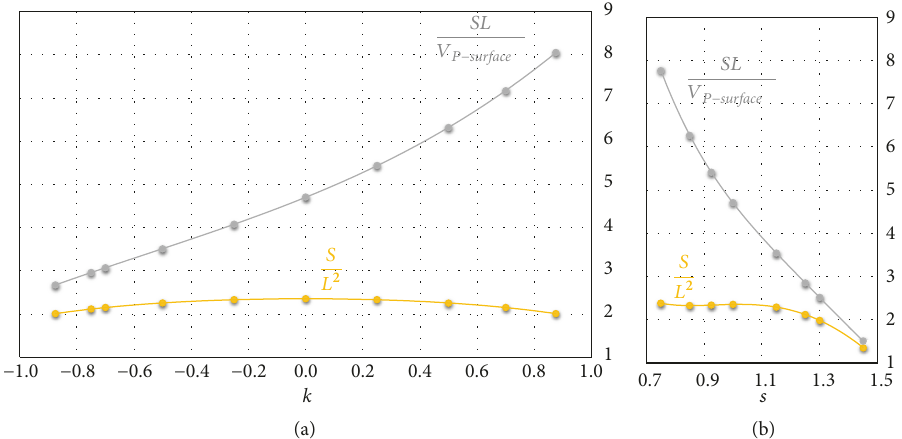
Figure 6: Trend of area-volume and surface ratio for a P-cell with (a) 𝑠 = 1 and 𝑘 ∈] − 1 1[ and (b) 𝑘 = 0 and 𝑠 ∈ [0.75 1.5[ .